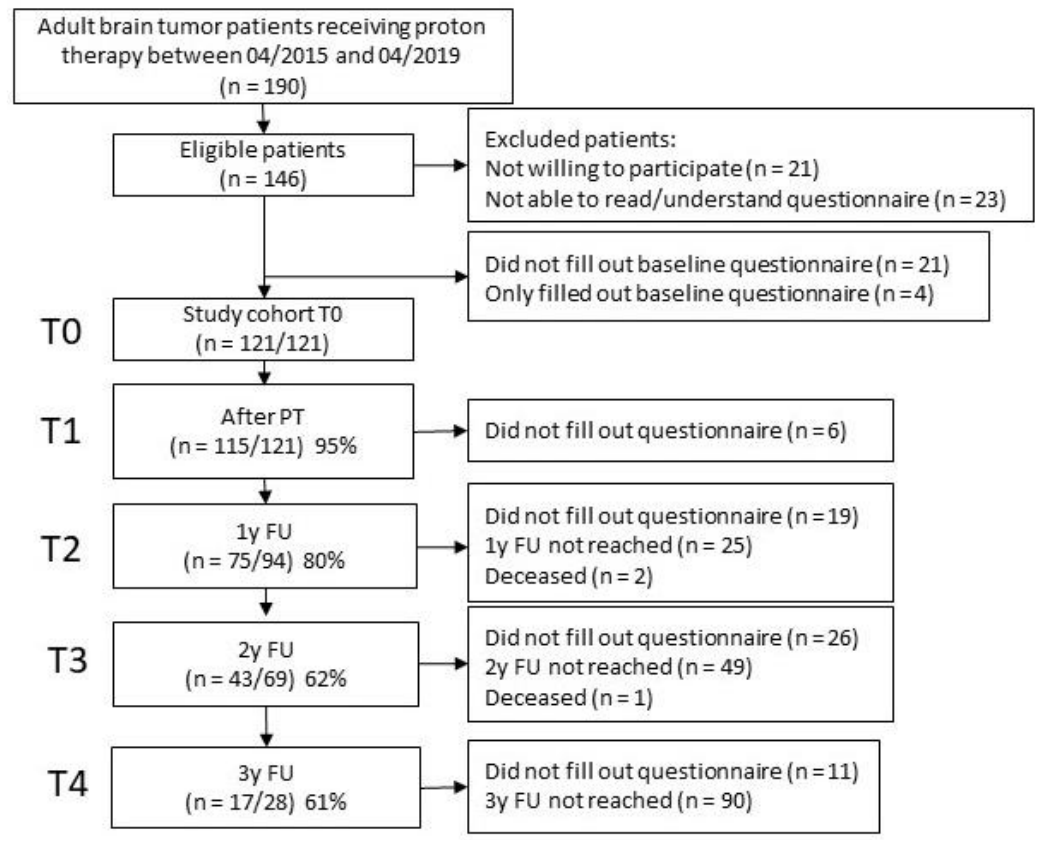
Figure 1. Flow diagram of patient inclusion and follow-up.